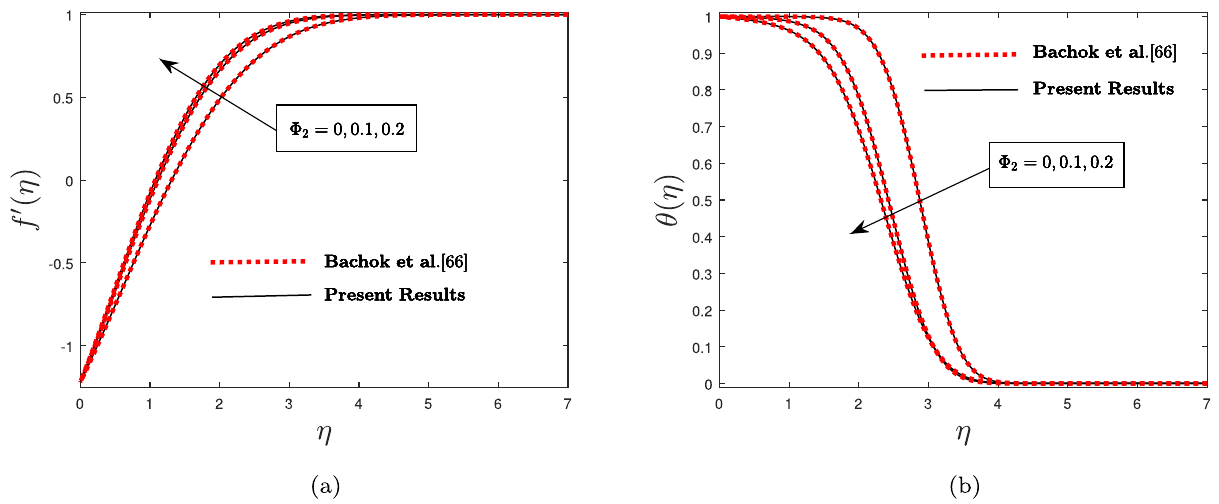
Figure 3: Comparison of the present results of fl ow pro fi les with Bachok et al . [ 65 ] for Cu/H 2 O SNF. ( a ) Velocity fi elds against di ff erent Φ 2 ( = = Φ Φ 0 1 3 ) and ( b ) temperature fi elds against di ff erent Φ 2 ( = = Φ Φ 0 1 3 )